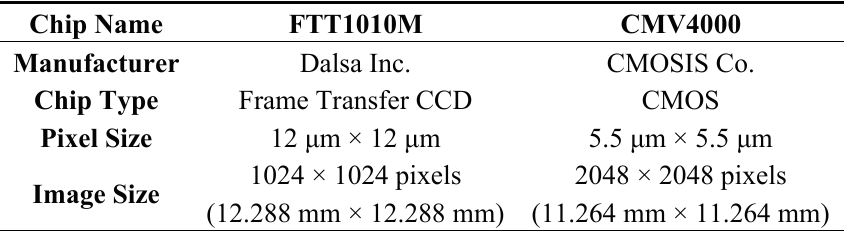
Table 2. Comparison of the two imaging